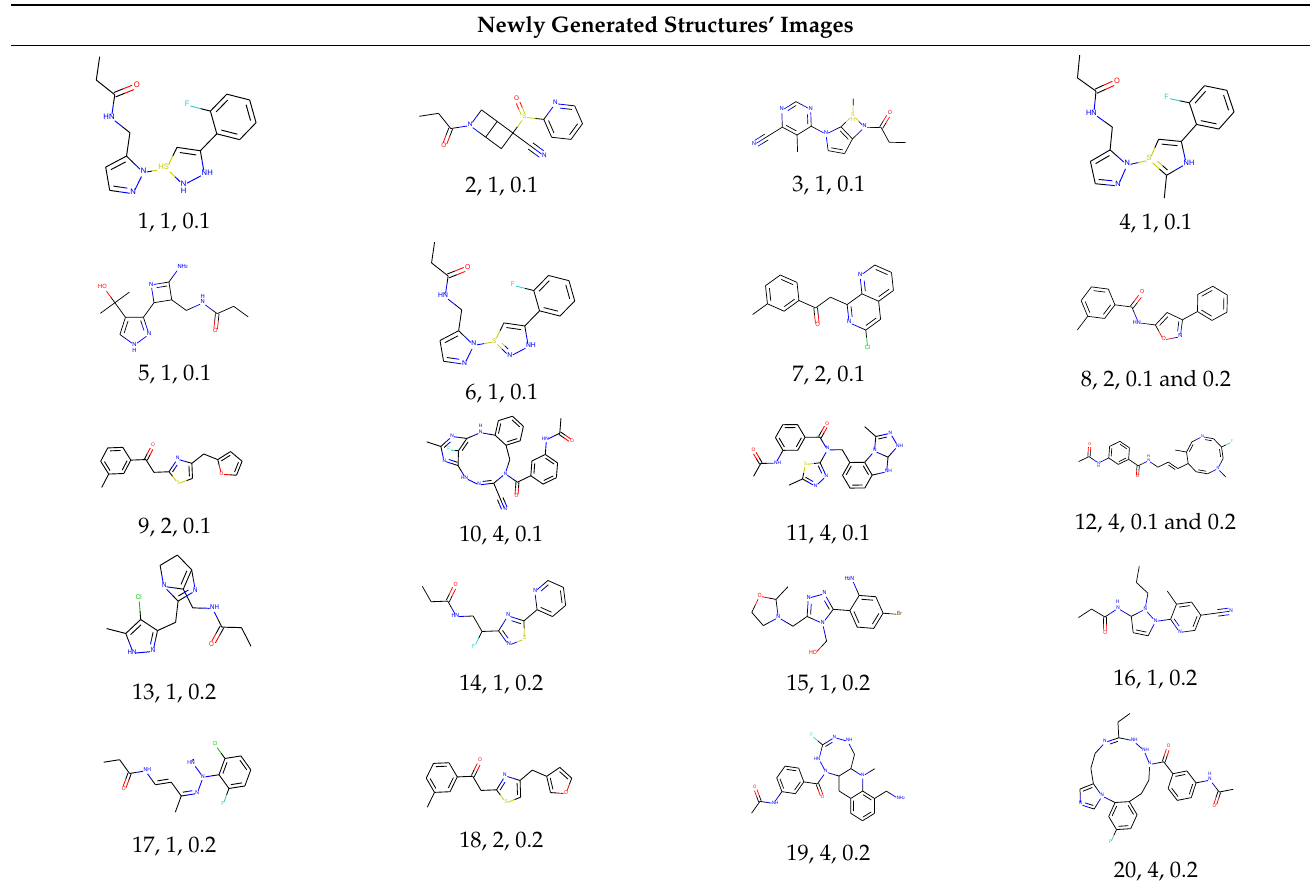
Table 1. The structures of selected molecules. The table contains structure, structure number, structure of origin number, tensor scaling mode. Newly Generated Structures’